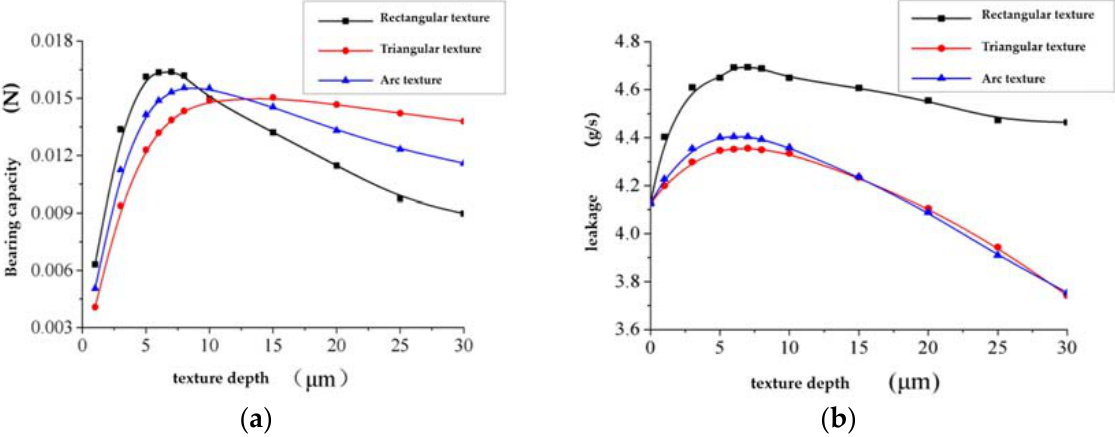
Figure 7. Effect of texture depth on sealing performance. ( a ) Effect of texture depth on bearing capacity; ( b ) Effect of texture depth on leakage.